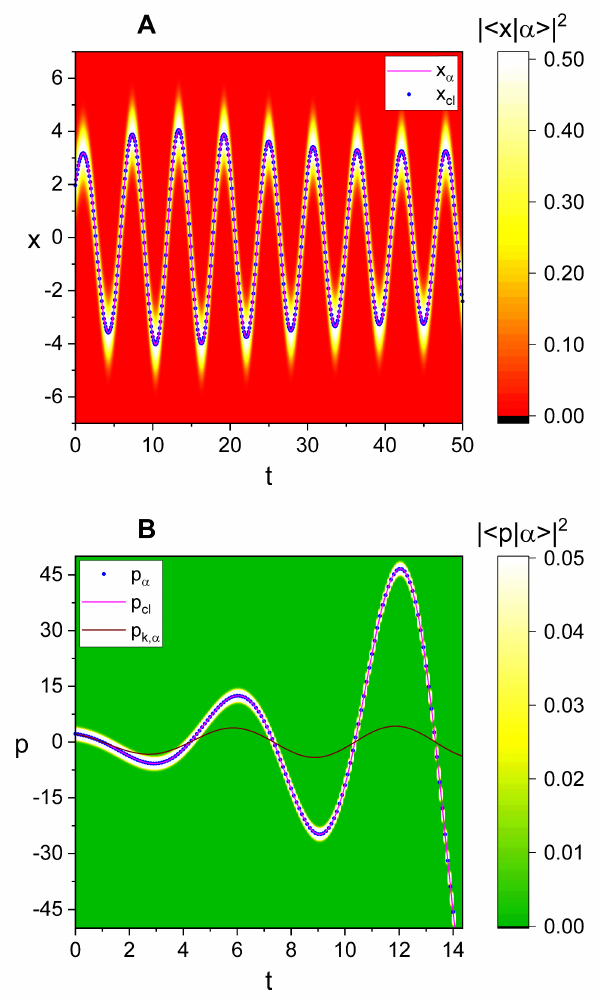
Figure 6. ( A ): Comparison of the time evolution of the probability density |(cid:104) x | α (cid:105)| 2 (density plot) with that of the quantum expectation value x α ( = (cid:104) α | ˆ x | α (cid:105) ) and its classical counter part x cl represented in Equation (A4). ( B ): Comparison of the time evolution of the momentum probability density |(cid:104) p | α (cid:105)| 2 (density plot) with that of the quantum expectation value p α ( = (cid:104) α | ˆ p | α (cid:105) ), p cl (Equation (A5)), and the expectation value of the physical momentum p k, α ( = (cid:104) α | ˆ p k | α (cid:105) ). ω = 1.1 is used for both panels ( A , B ); this case corresponds to near resonance like that of the green curves in Figure 3. Other values that we have used are γ e = 0.2, ω e = 1, ϕ = 0, α 0 = 3, m = 1, ¯ h = 1, f d = 1, and A 0 =